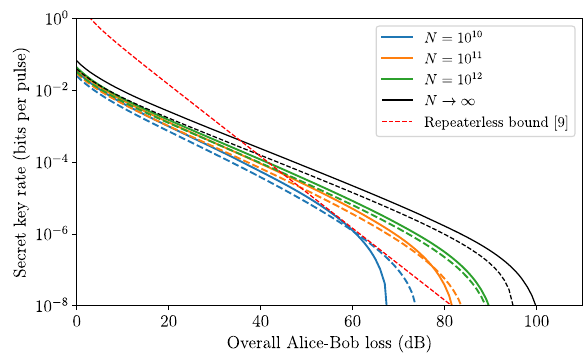
Fig. 5 Comparison between this work (solid) and the alternative analysis in ref. 40 (dashed). We consider different values for the block size N of transmitted signals. All other simulation parameters are stated in the main